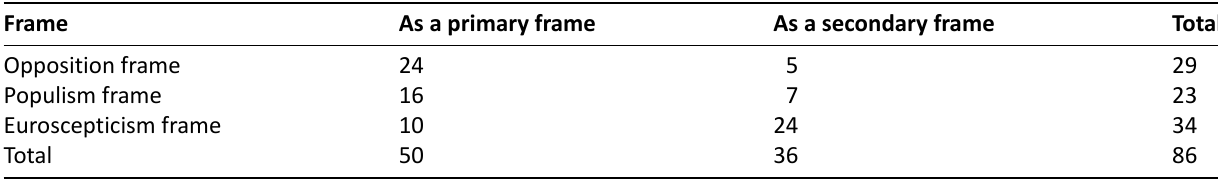
Table 2. Main frames of Finns Party (PS) in Euro crisis articles (n = 59).